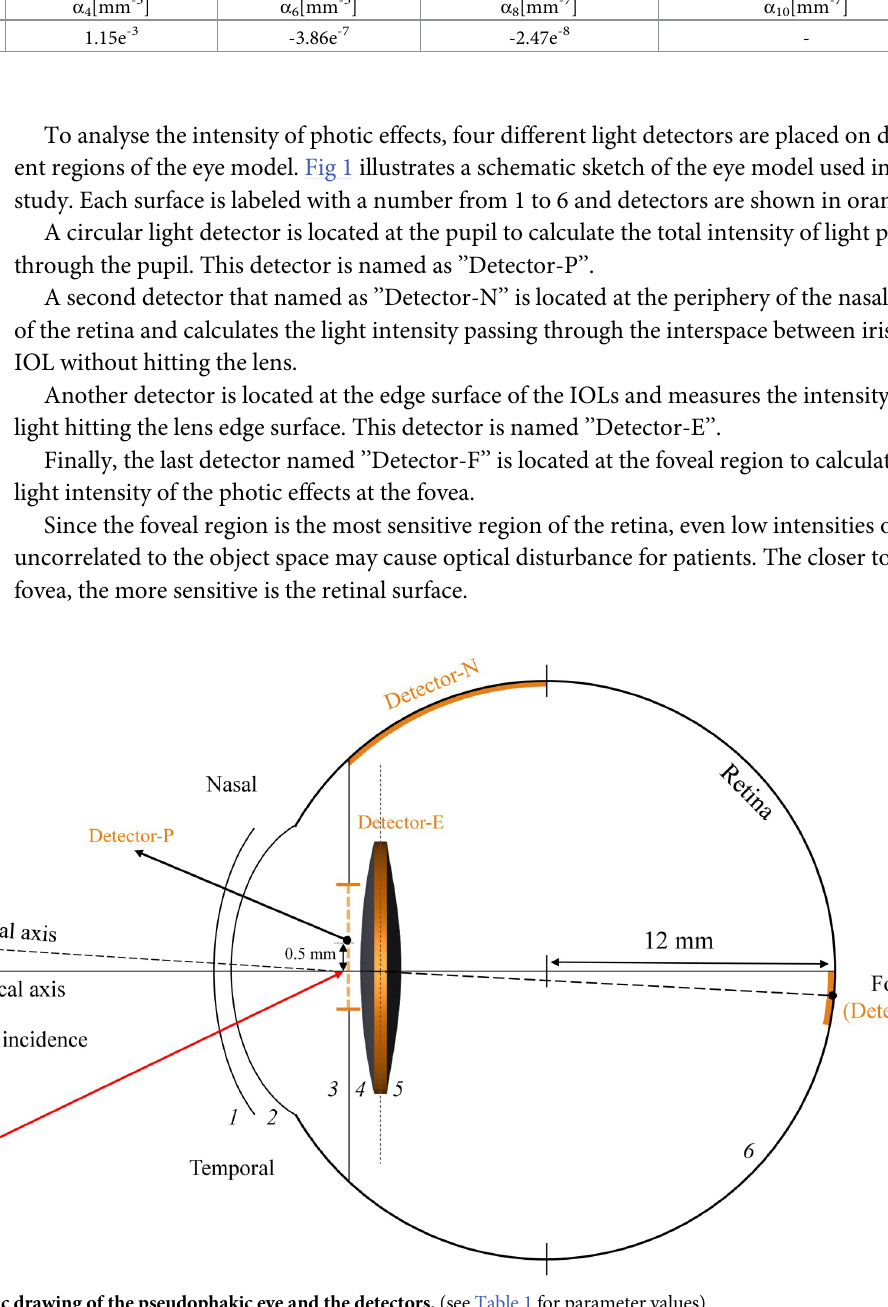
Fig 1. Schematic drawing of the pseudophakic eye and the detectors. (see Table 1 for parameter values).